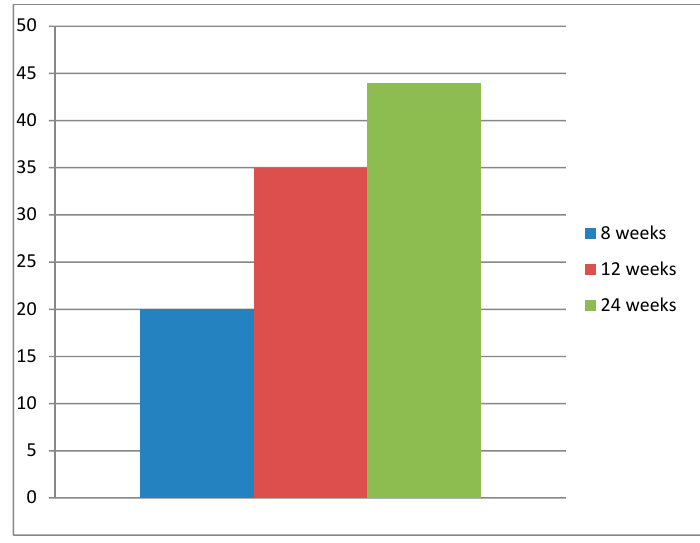
Figure 3. Percent paid work (y-axis), mean values, one year after start of rehabilitation, for the patients participating in the different rehabilitation periods.